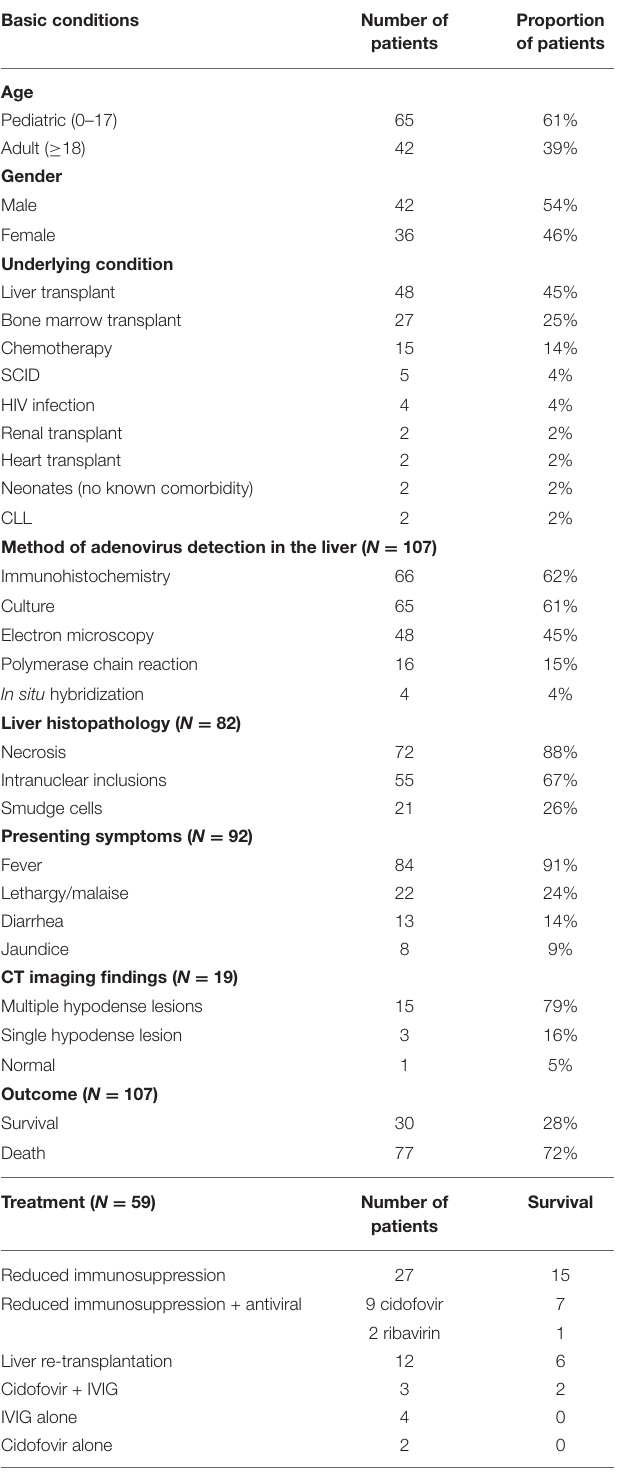
TABLE 2 | Characteristics of 107 patients with HAdV hepatitis. TABLE 3 | Characteristics of HAdV